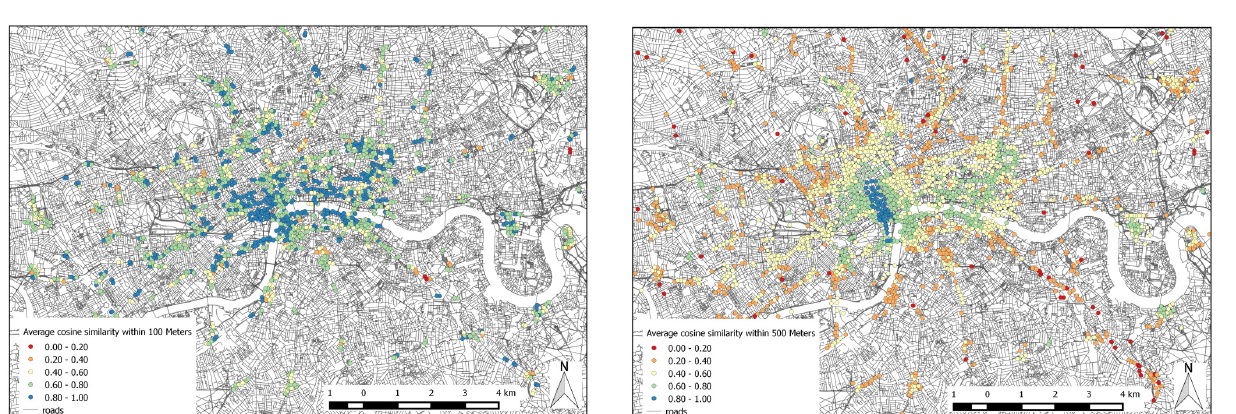
Figure 7: Kendall's Tau for all Twitter places